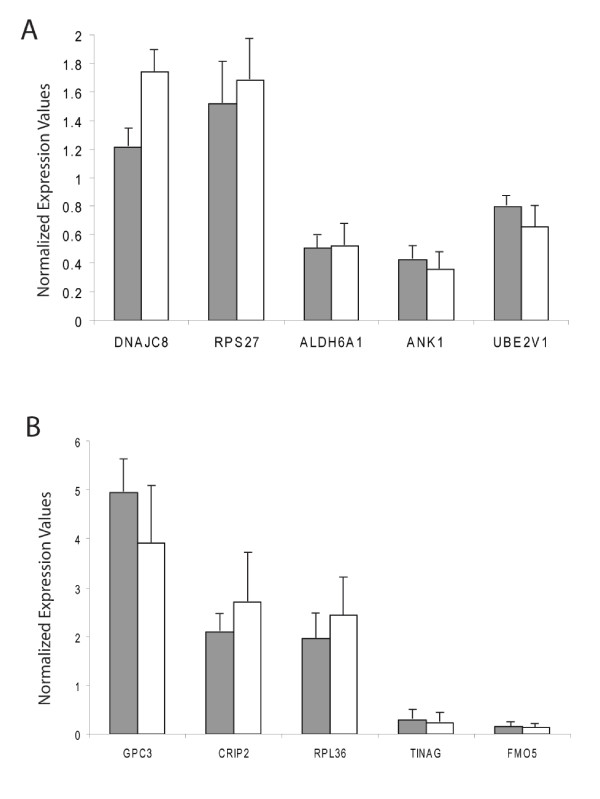
Selection of genes differentially expressed during hibernation in heart (A) and liver (B) tissue in black bears. Expression values are normalized to the mean in summer active animals. Solid bars show expression values obtained in real-time PCR, open bars in microarray experiments, error bars are SDs.